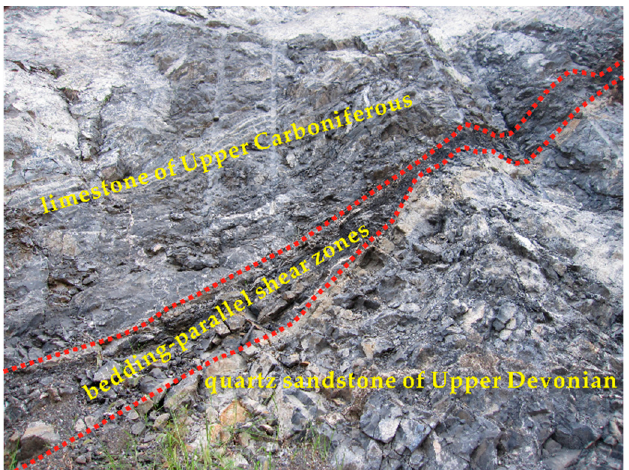
Figure 21. Field photograph of outcropped bedding-parallel shear zone between limestone of Upper Carboniferous and quartz sandstone of Upper Devonian in the Xinqiao deposit.